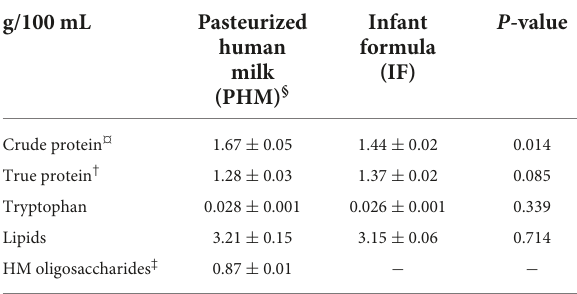
TABLE 1 Protein, tryptophan, lipid, and HM oligosaccharide content of pasteurized human milk § (PHM) and the infant formula (IF) (mean ±